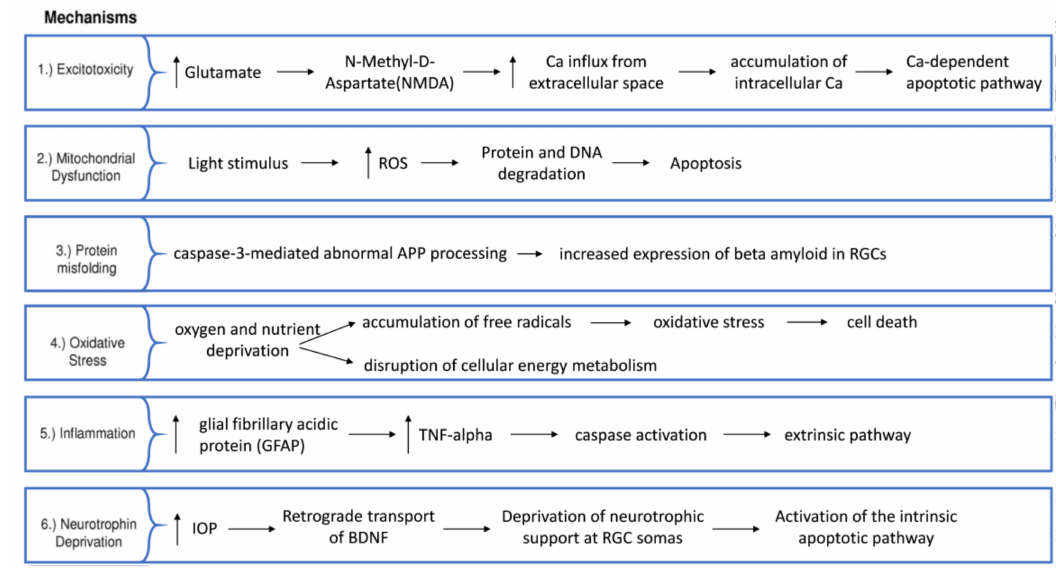
Figure 2. Glaucoma pathophysiological pathways (APP: amyloid precursor protein, upwards arrow: